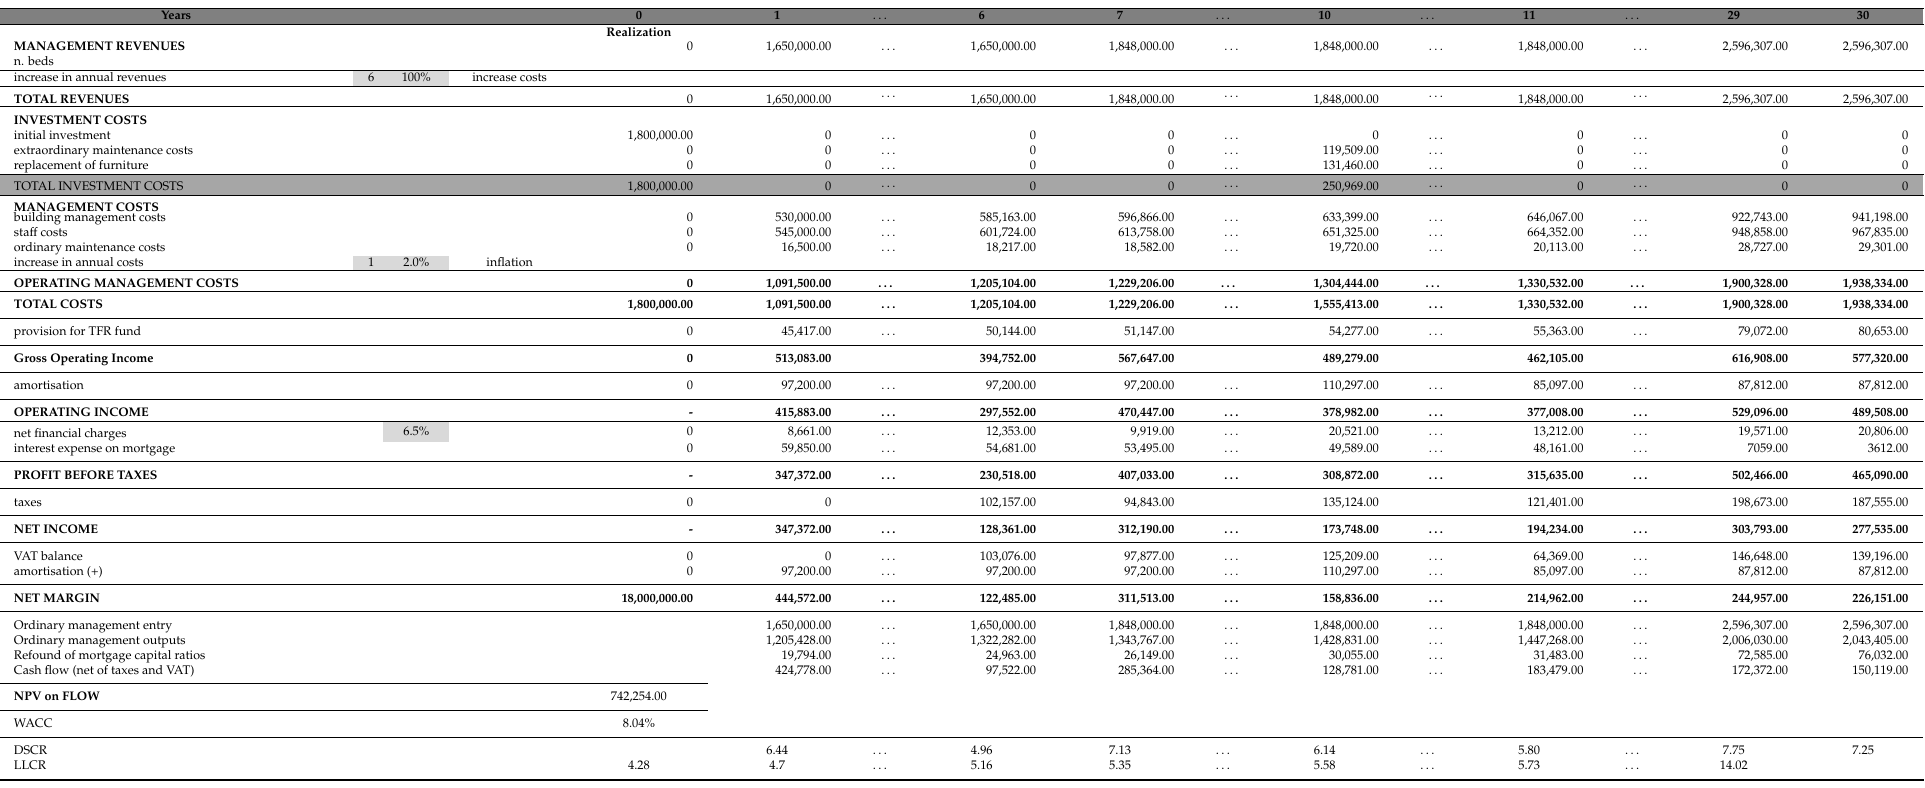
Numbers in bold highlight the totals of the overlying